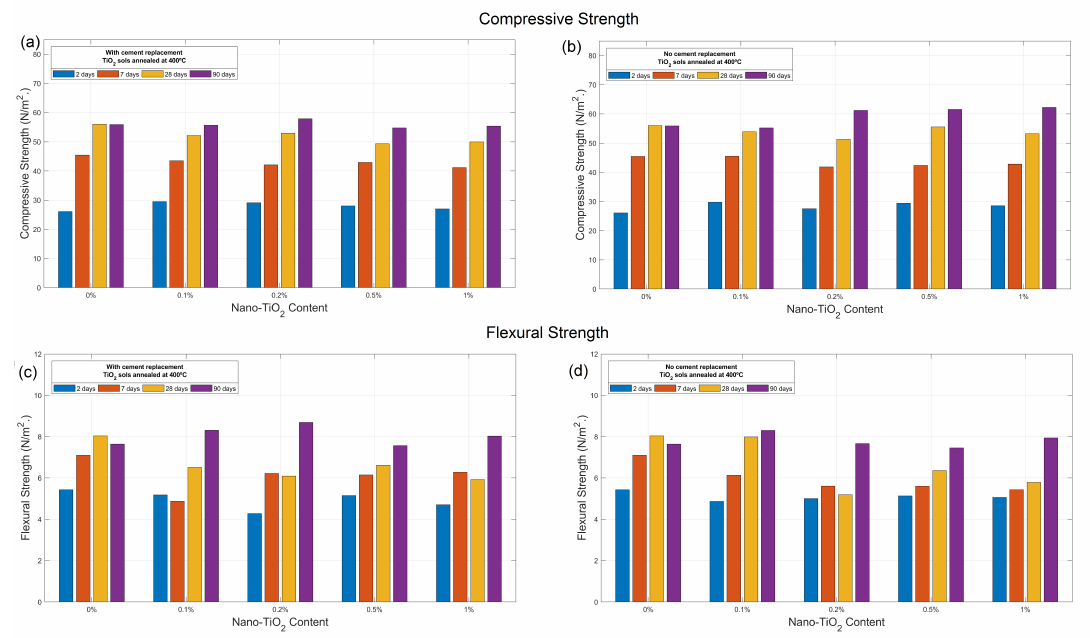
Figure 5. ( a , b ) Compressive and ( c , d ) flexural strength of cement composites containing nano-TiO sols annealed at 400 ◦ C, with and without cement replacement.